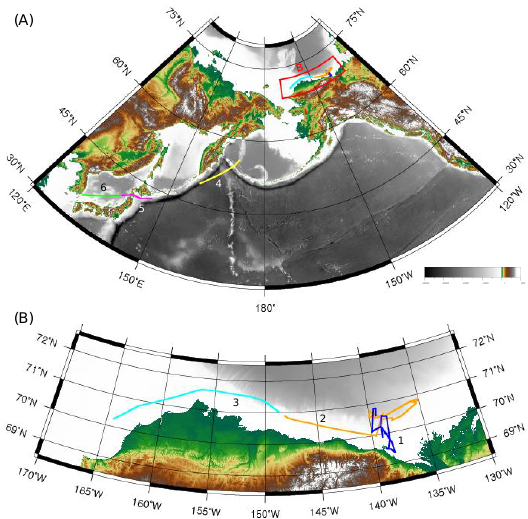
Figure 1. ( A ) Cruise tracks of the ARA08 cruise corresponding to each sample with the quartz fiber filter identification numbers used. ( B ) Detailed cruise tracks for the Arctic samples with the quartz fiber filter identification numbers used.